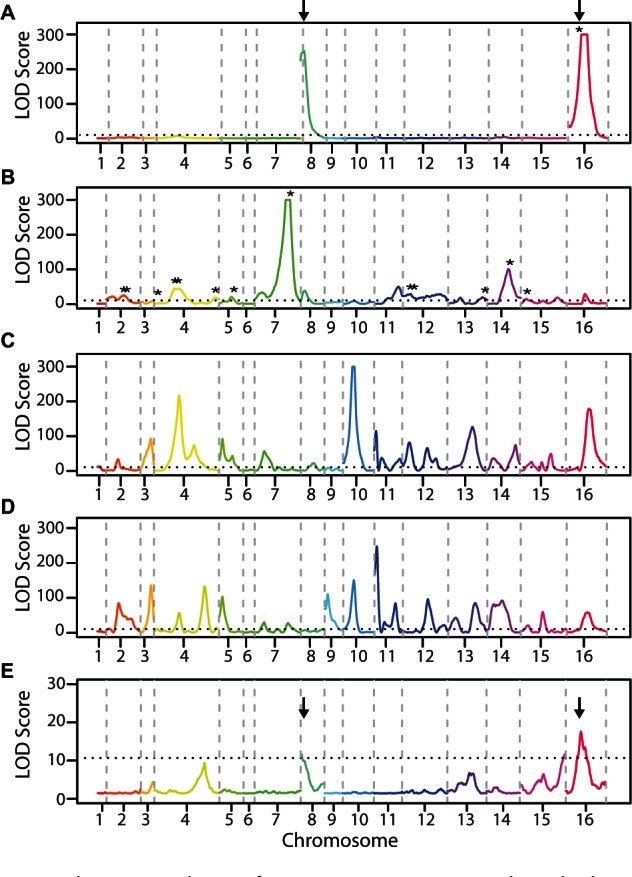
The genetic basis of stress resistances. QTL plots displaying MULTIPOOL LOD scores across all 16 chromosomes for tolerance to grape juice (A and B), Congo red (C and D), and rich YPD medium (E) in Cross 1 (A, C, and E) and Cross 2 (B and D). Each chromosome is plotted in a different color and gray vertical dashed lines mark chromosomal boundaries. Black horizontal line shows LOD 10.68 threshold for significance. Asterisks (*) in (A) and (B) show locations of chemical genomic hits that fall within 90% credible intervals for identified QTL. Arrows show the breakpoints of the Chr 8:16 translocation, see text for details.